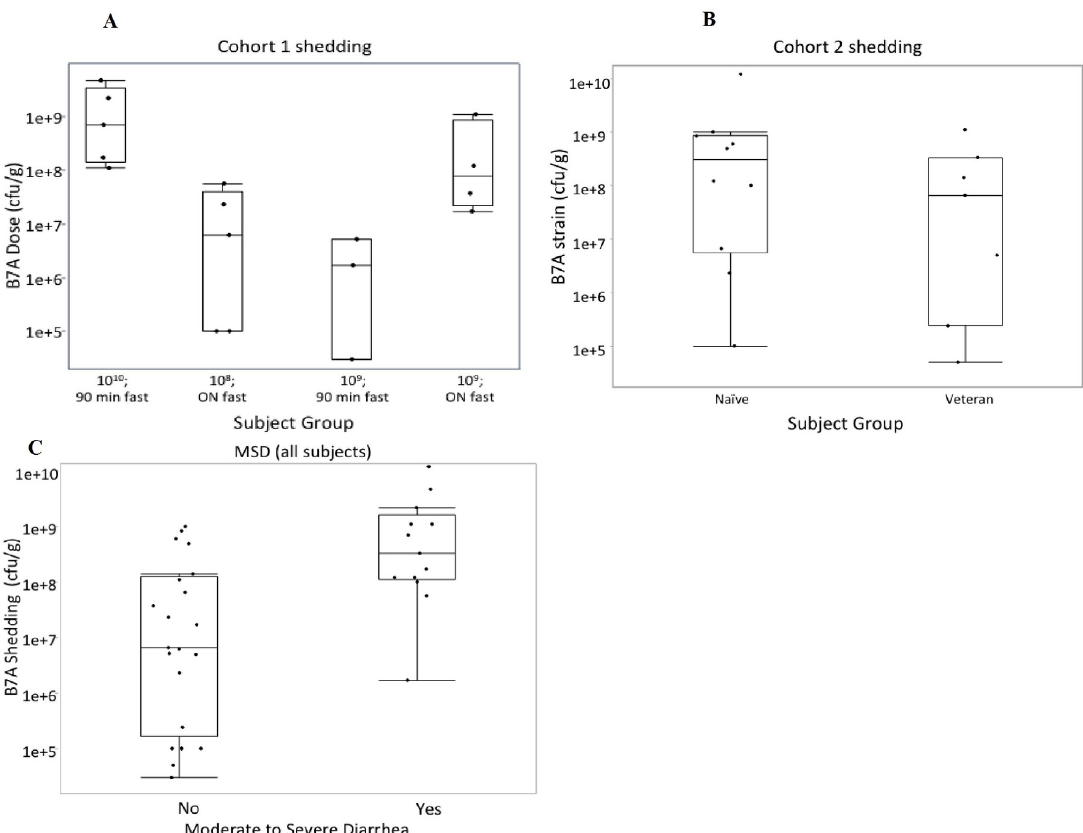
Fig 3. Comparison of median shedding 2 days after challenge with ETEC strain B7A based on (A) subjects in Cohort 1 (B) subjects in Cohort 2 and (C) subjects with and without moderate-severe diarrhea. The shedding value for each subject is represented by a dot on the figure based on (A) the dose/fasting time to which that subject was randomized, (B) veteran status, and (C) whether the subject experienced MSD. The horizontal line within the box represents the median sample value. The ends of the box represent the 1st and 3rd quartile. The whiskers extend from the ends of the box to the outermost data point that falls within the distances computed as 1st/3rd quartile—1.5 � (interquartile range). Quantitative shedding was not evaluated for subjects who had initiated antibiotic treatment or did not produce a stool sample at the time